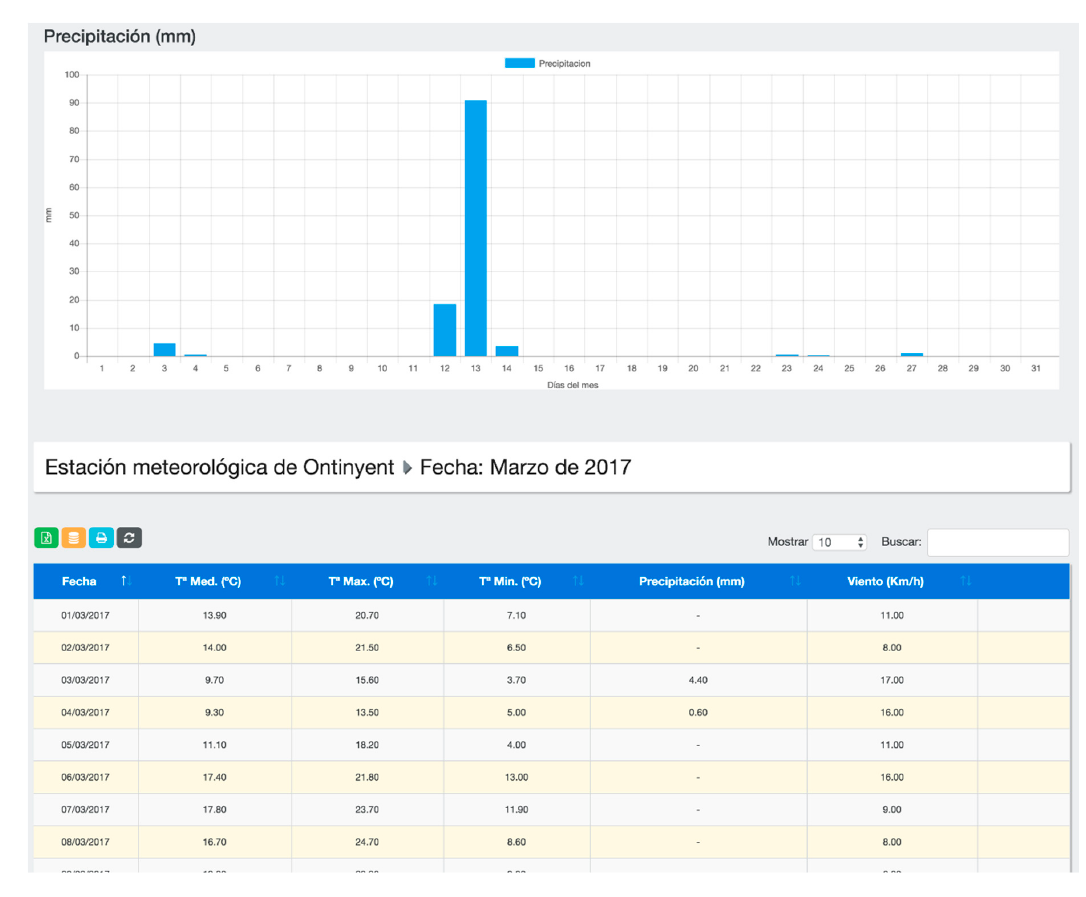
Figure 15. Example of climatological data from the AEMET climate station, located in Ontinyent Figure15. (Valencia).